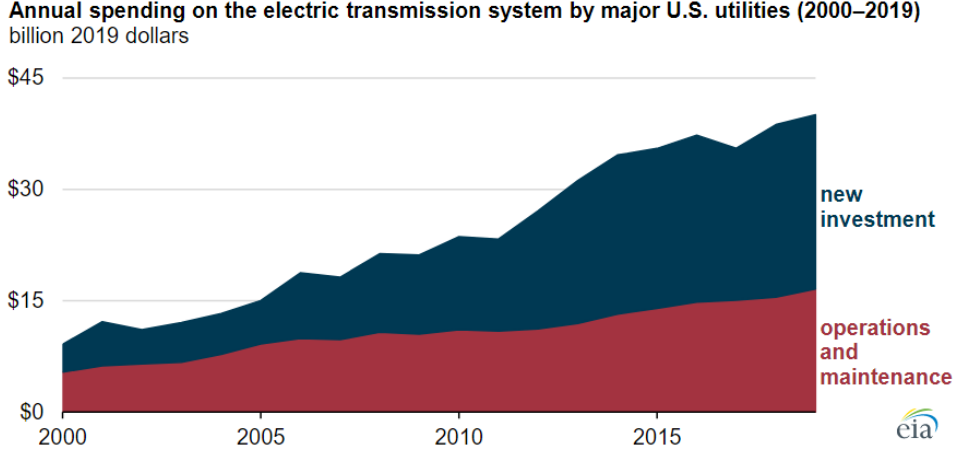
Figure 3. Electricity transmission cost. Source: US Department of Energy, Energy Information Administration [17].